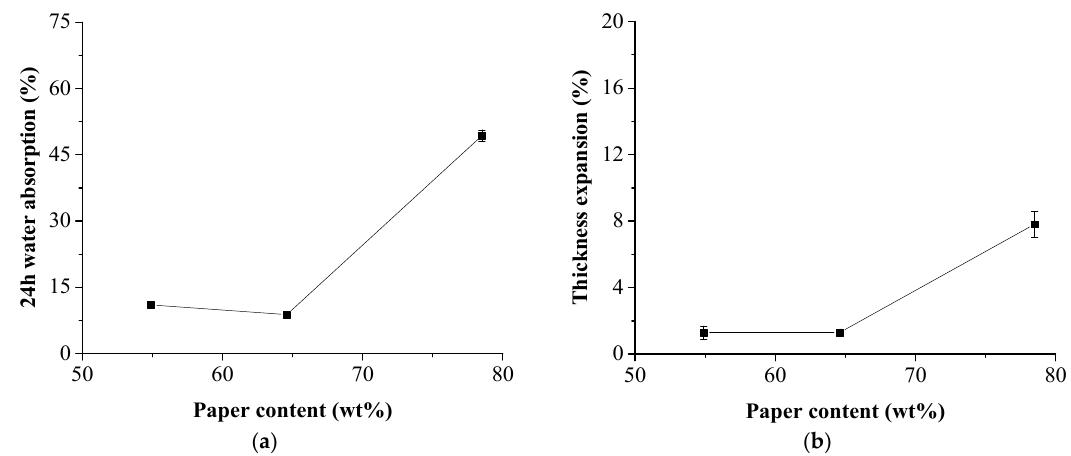
Figure 5. Effects of NP content on water absorption and thickness expansion of the composites. ( a ) 24-h water absorption; ( b ) thickness expansion.